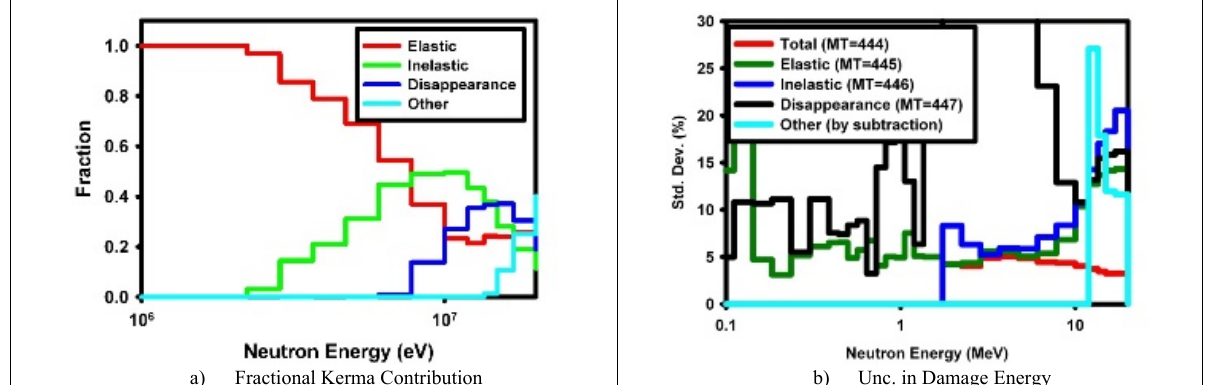
Fig. 5. Energy-dependent components of the 28 Si kerma (left) and the associated energy-dependent uncertainty in the damage energy